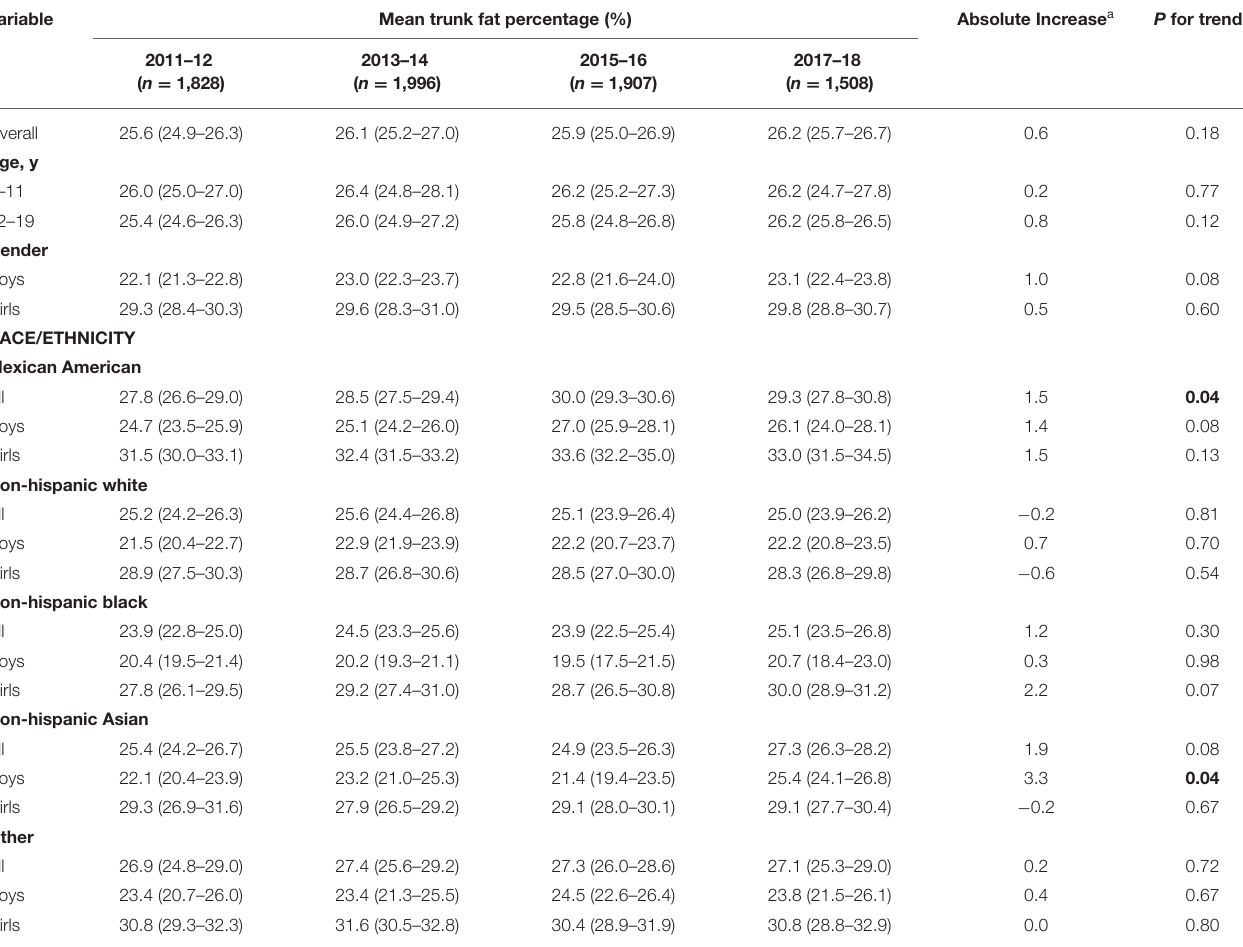
TABLE 2 | Trends in mean trunk fat percentage (95% CI) by race or ethnicity among US children aged 8–19 y, NHANES 2011–2012 to